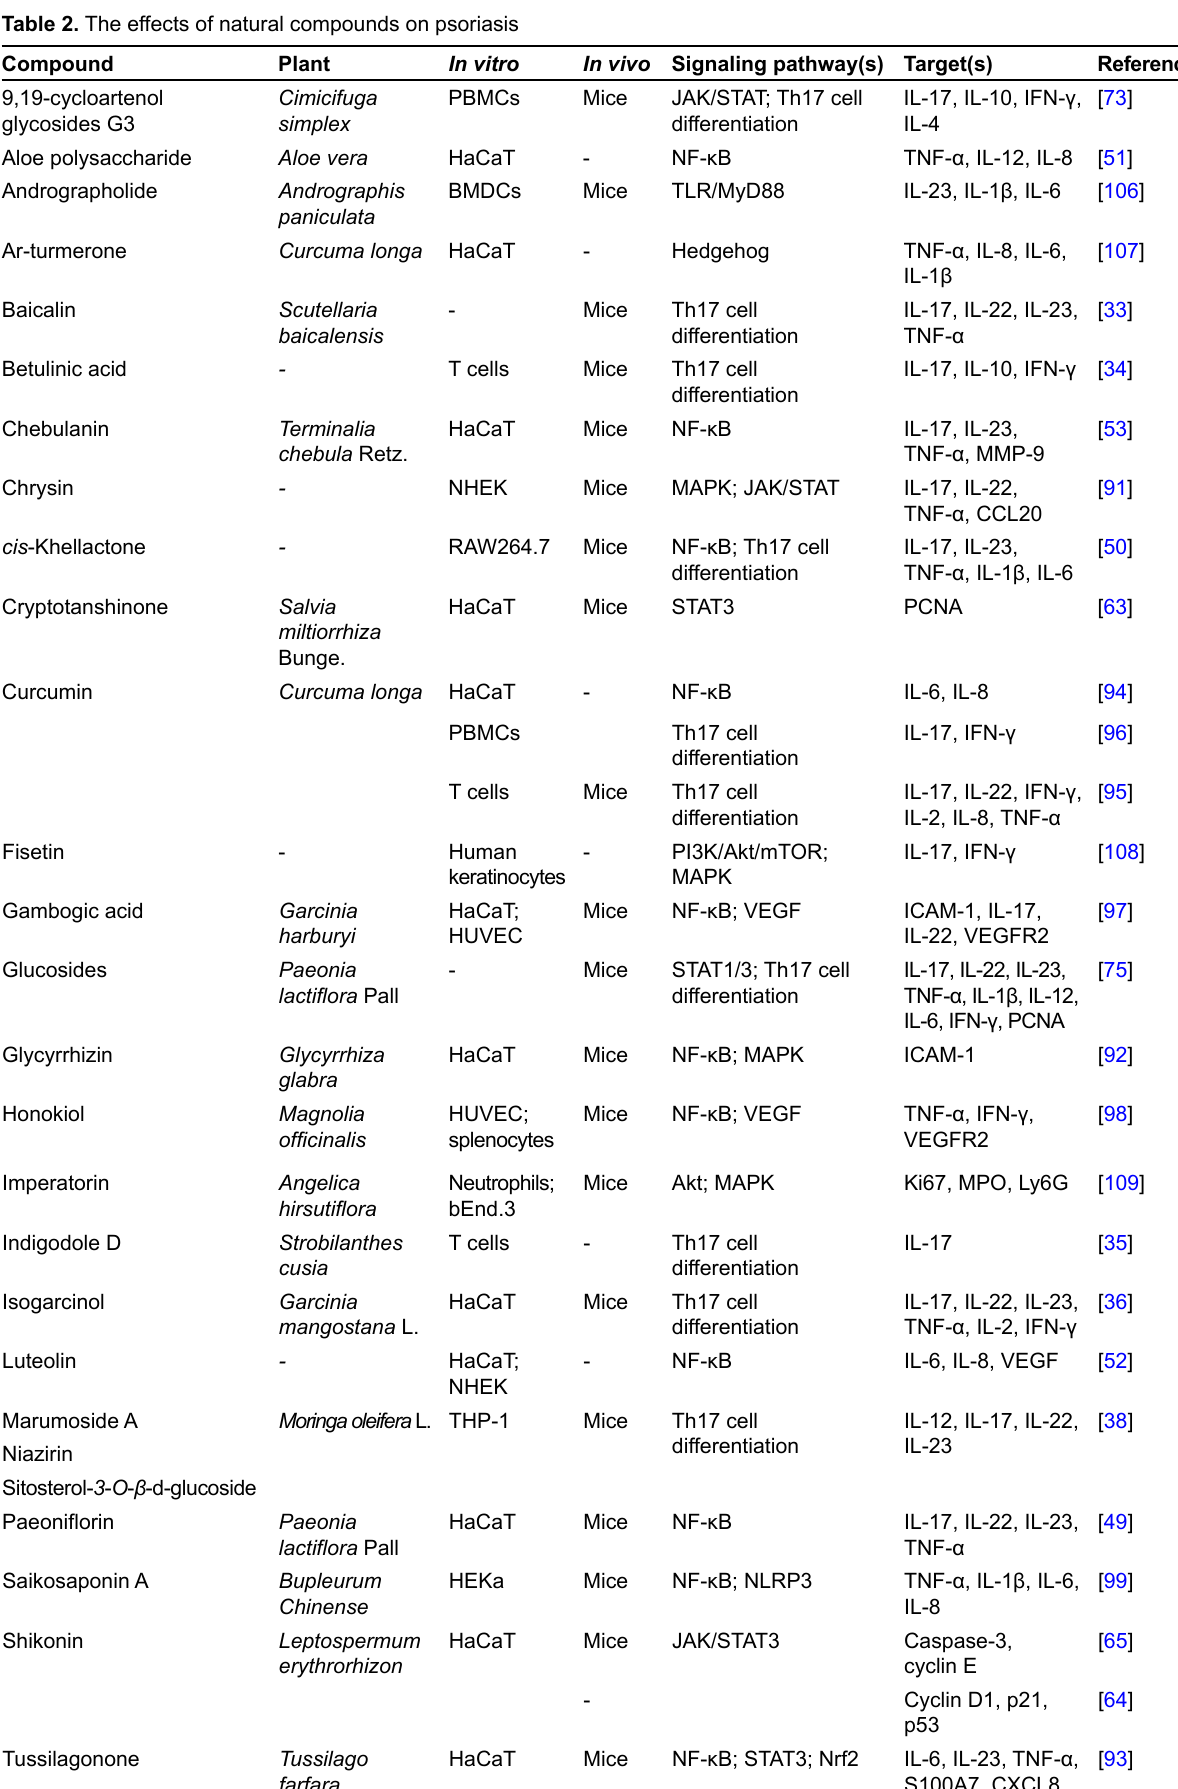
Table 2. The effects of natural compounds on